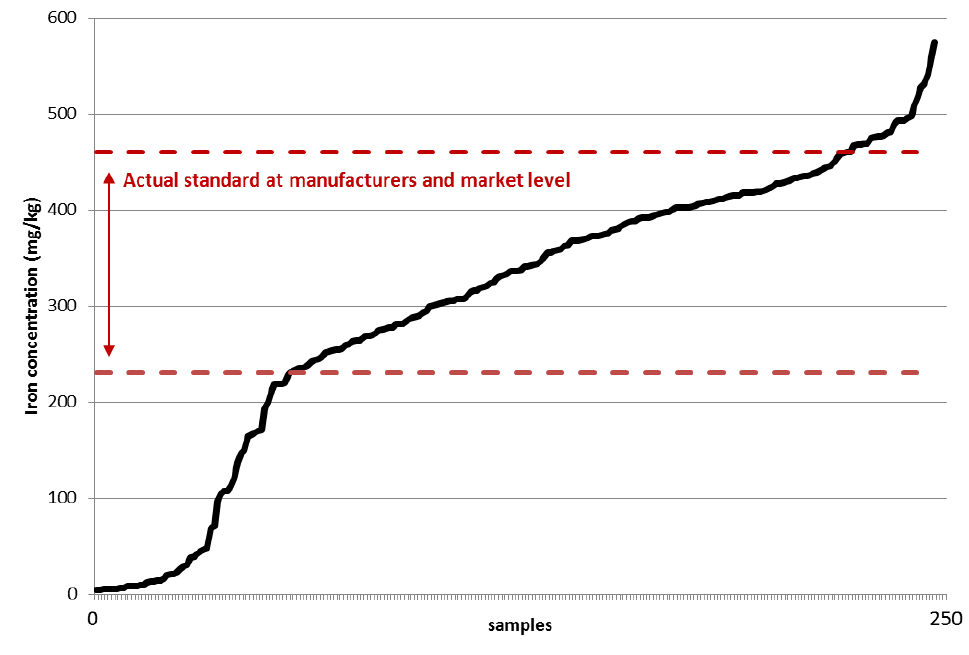
Figure 2. Iron values (mg/kg) in fish and soy sauces (sorted by lowest to highest iron value).